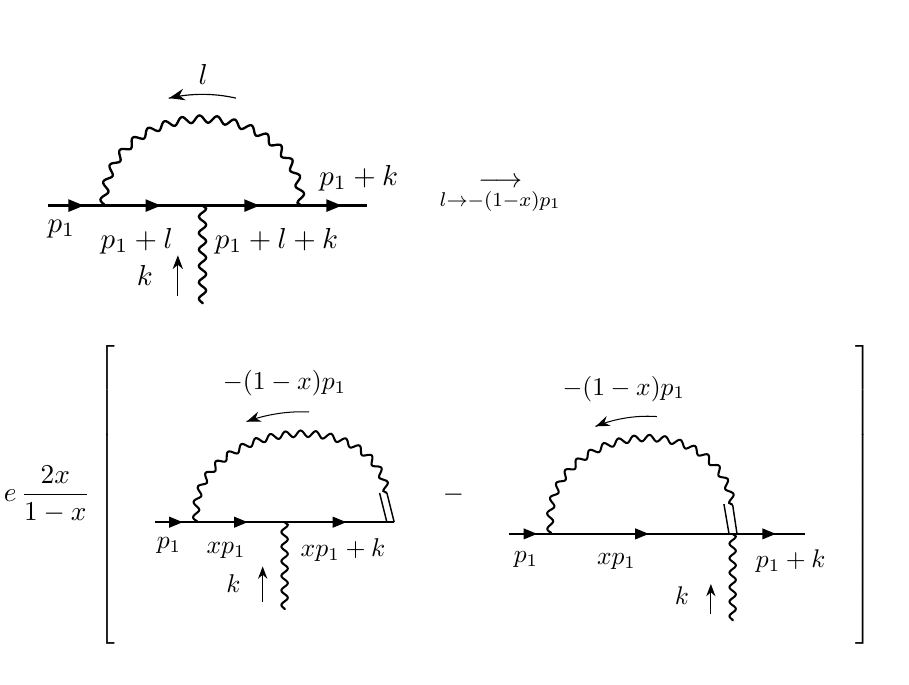
Figure 16. Result of the Ward identity in the l collinear to p 1